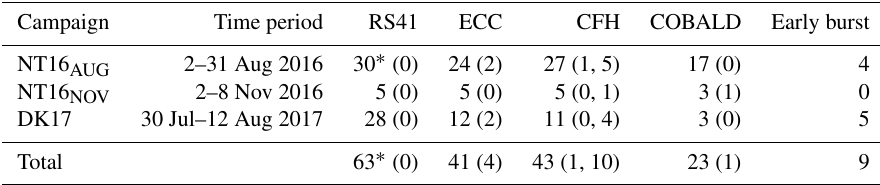
Table 2. Number of balloon soundings performed for each instrument and campaign period. The number of soundings with instrumental malfunctions is displayed in parentheses (CFH refers to the number of failures and contamination events, respectively). Early burst is defined as a burst altitude <25km.